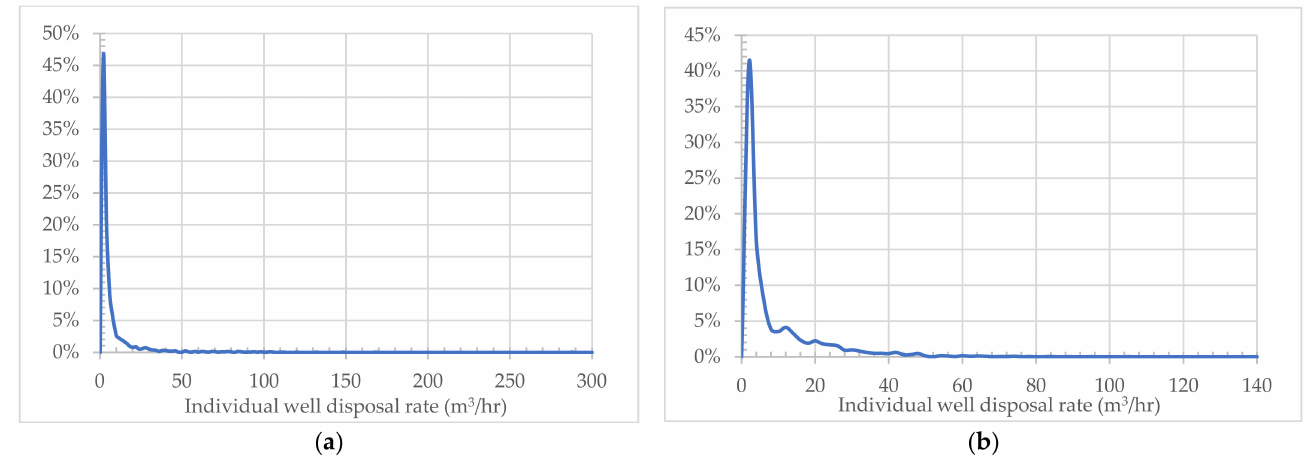
Figure A6. Historical per-well water injection rate ( X -axis) frequency ( Y -axis) distributions (January 1962–December 2022) in ( a ) the Grand Rapids Formation; ( b ) the Clearwater Sandstone